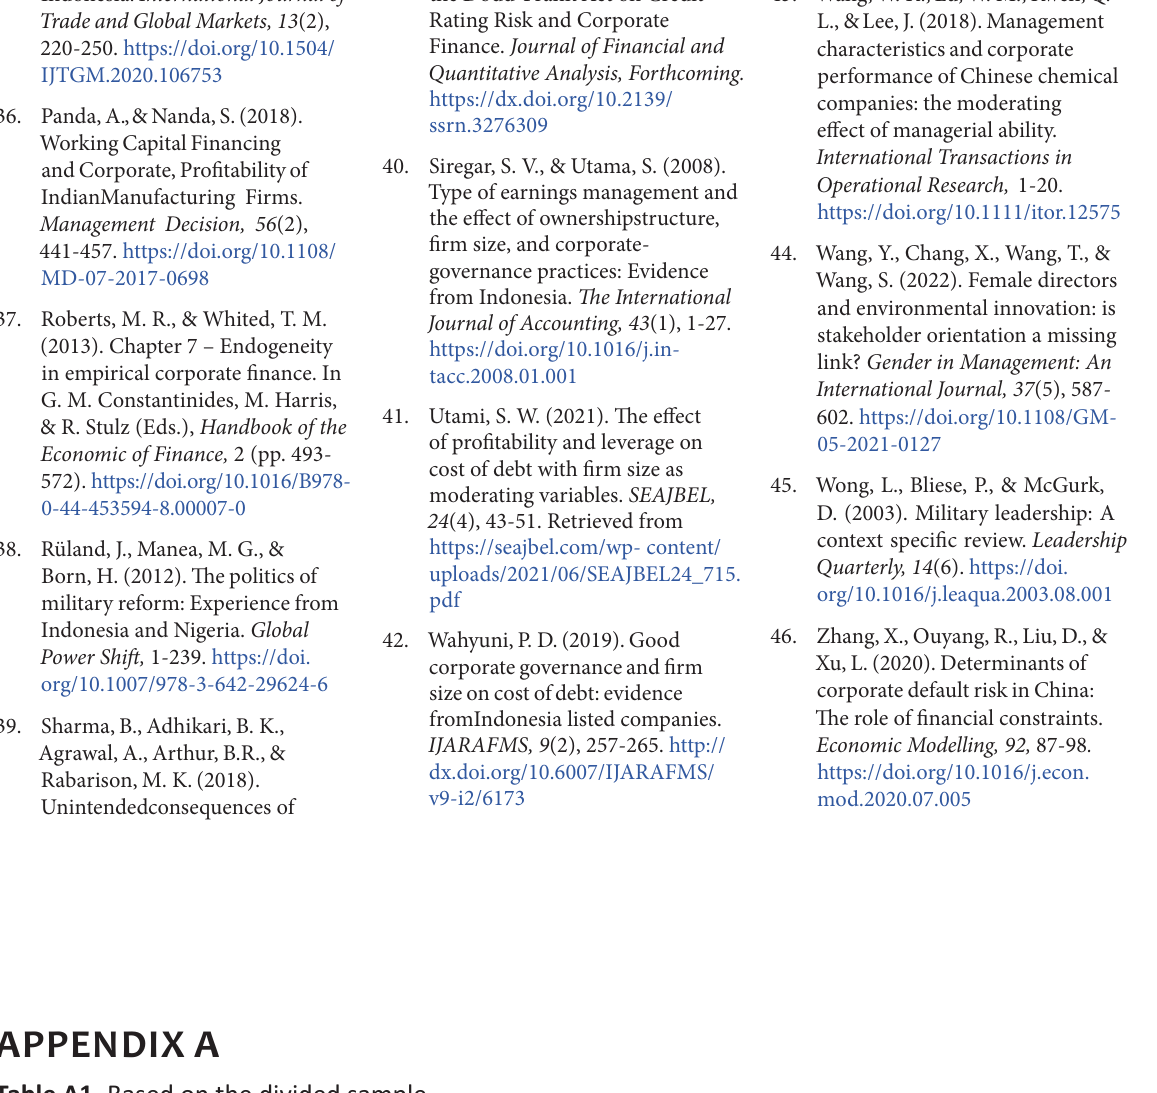
Table A1. Based on the divided